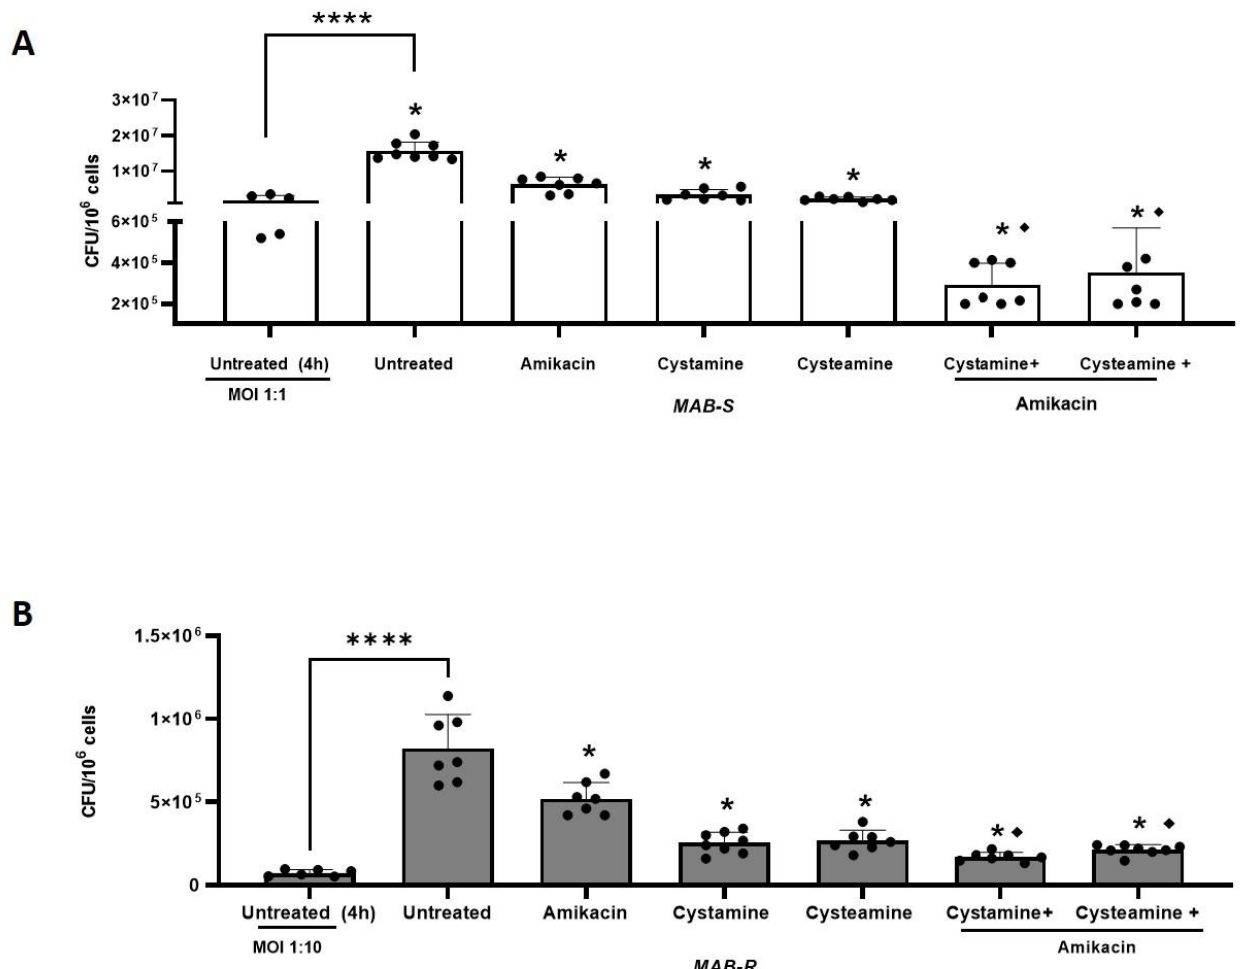
Figure 2. Enhanced effect of cysteamine/cystamine with amikacin. In ( A , B ), the THP-1 were infected with the R and S variants, respectively (the treatments and combinations with amikacin were added as described above). Two days after infection, cells were lysed to assess intracellular CFUs and the results are shown as Log CFU/10 6 cells. Box plots chart represented the mean and SD of three independent experiments. Data were analyzed by one-way ANOVA followed by the Tukey comparison test. * represents statistically significant difference of all treatments compared with untreated condition (**** p < 0.001); ♦ represents statistically significant difference of cysteamine and cystamine in combination with amikacin compared with amikacin alone (**** p < 0.001 for both variants).